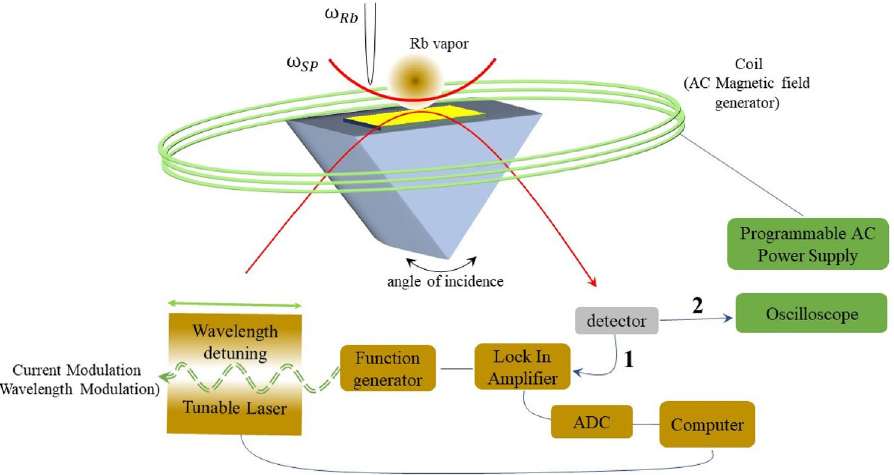
Figure 1. Part 1 (brown colored blocks) represent schematic diagram of the wavelength modulation spectroscopy used to measure reflectance from boundary of coated Au film and Rb vapor. Part 2 (green colored block) represent setup for modulation of magnetic field. Modulated electric current flows in represented coil and produces desired ac magnetic field applied to atom-SP boundary on